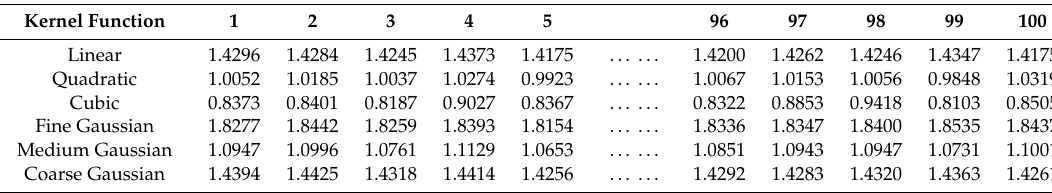
Table 4. RMSE values of di ff erent kernel functions.